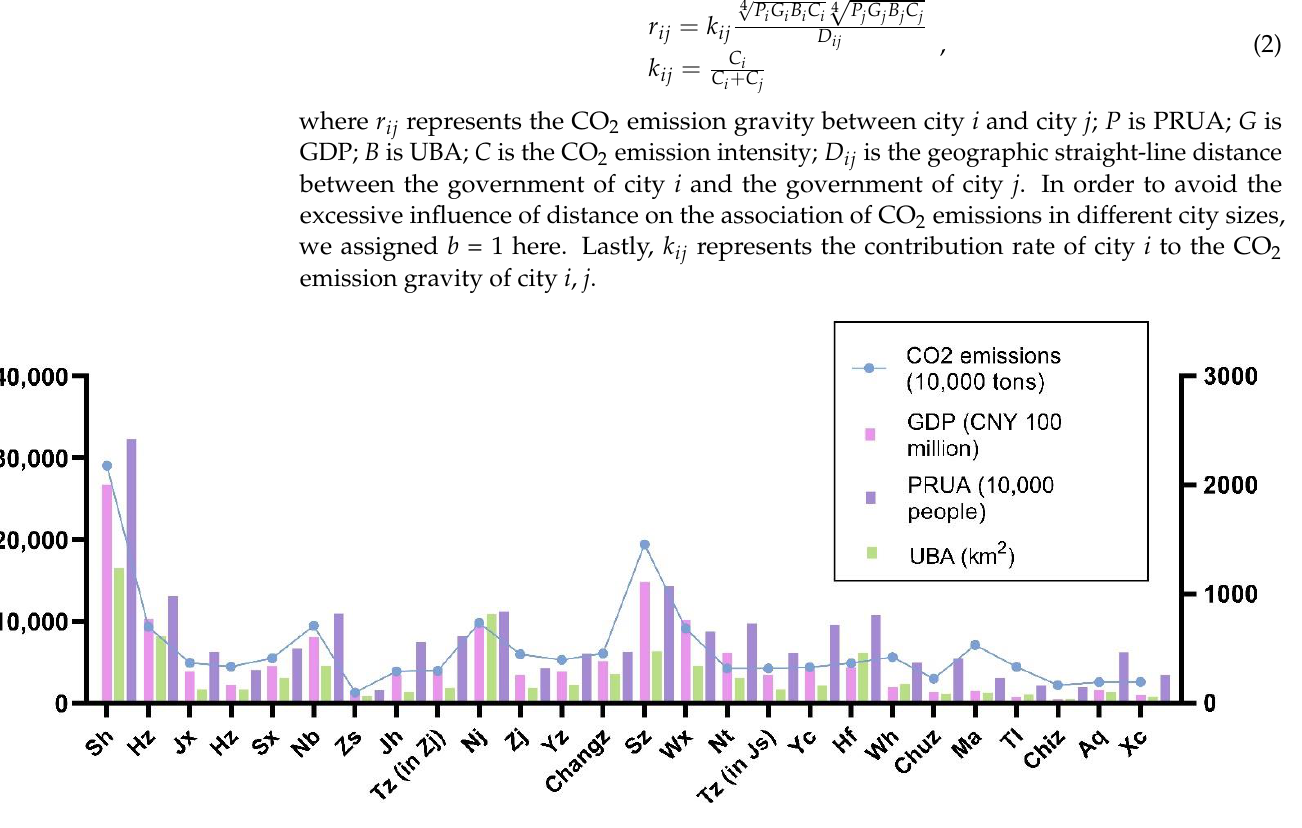
Figure 3. Statistics on the CO 2 emissions, GDP, PRUA, and UBA of the YRDUA’s twenty-six cities in 2018.